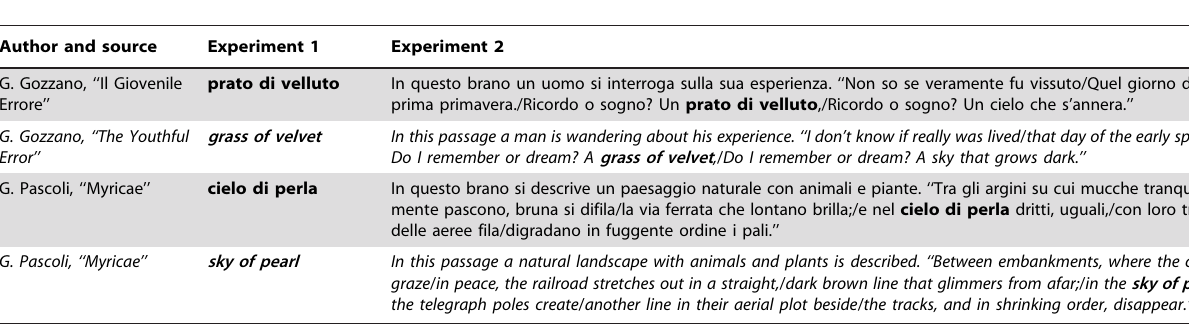
Table 1. Examples of literary metaphors in isolation (Experiment 1) and in original contexts (Experiment 2).